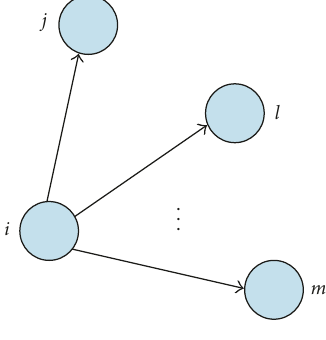
Figure 2: Multiple transmissions from node i